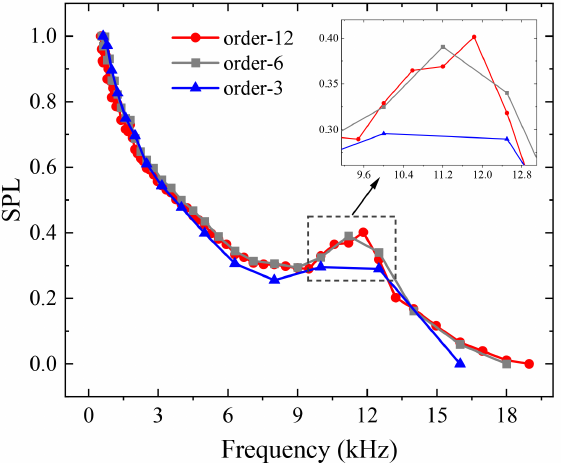
Figure 10. Octave performance with different orders for cracked WTB